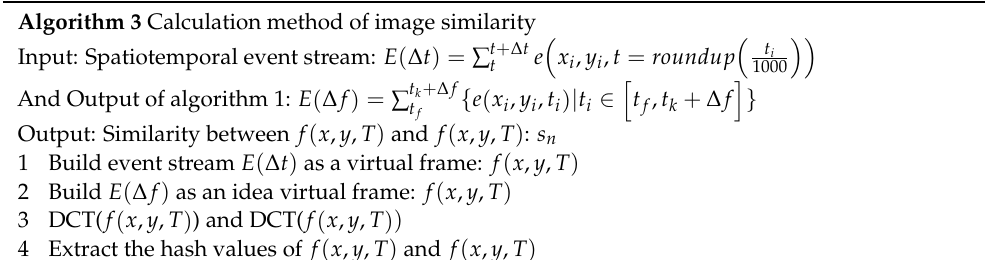
Algorithm 3 Calculation method of image